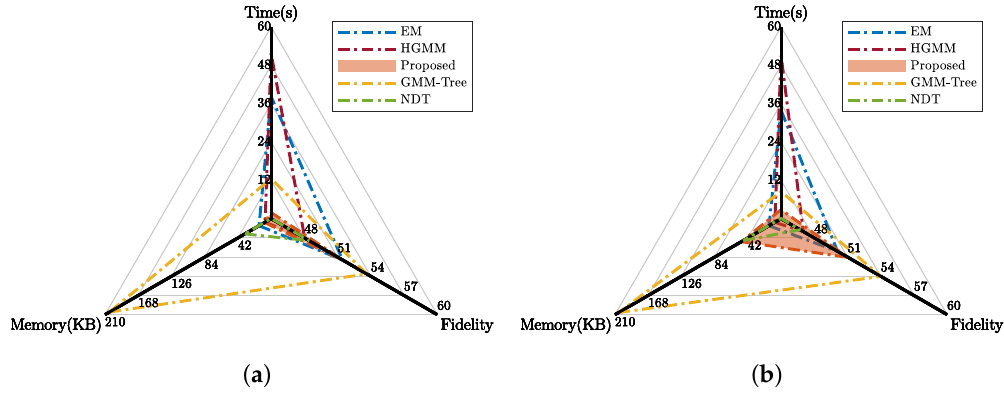
Figure 5. The mean value of fitting time, fidelity, and memory footprint of RGB-D datasets using different approaches. ( a ) Corner; ( b )